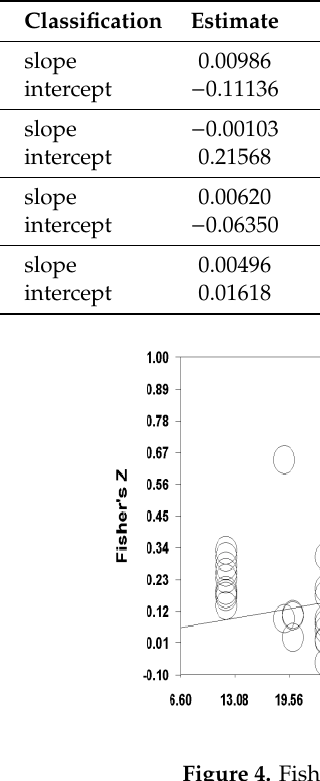
Figure 4. Fisher’s Z by the ratio of male subjects. Table 5. Results of the regression meta-analysis alongside the “absence of spouse”